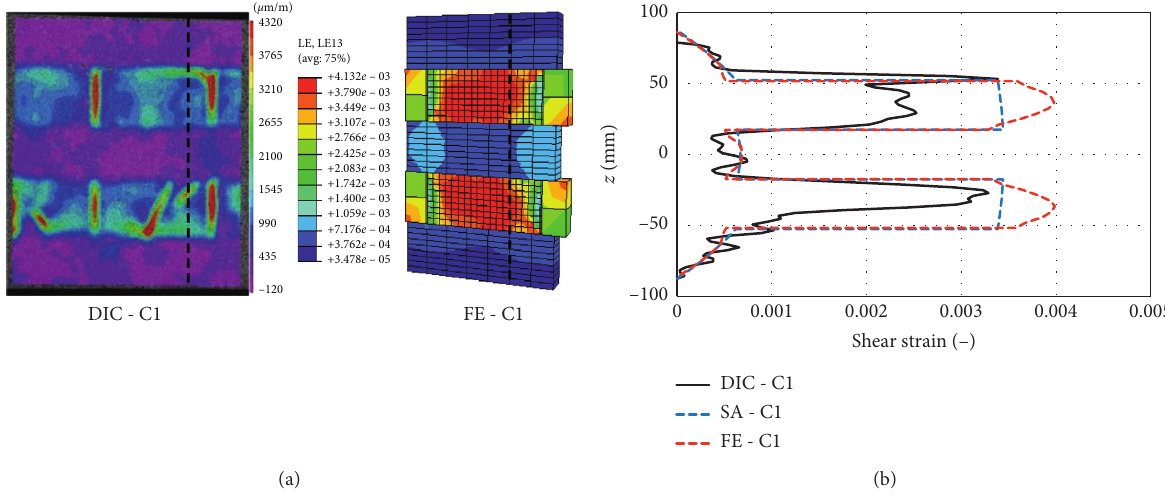
Figure 13: Colour contour plots and shear strain distribution from bending tests for C1.